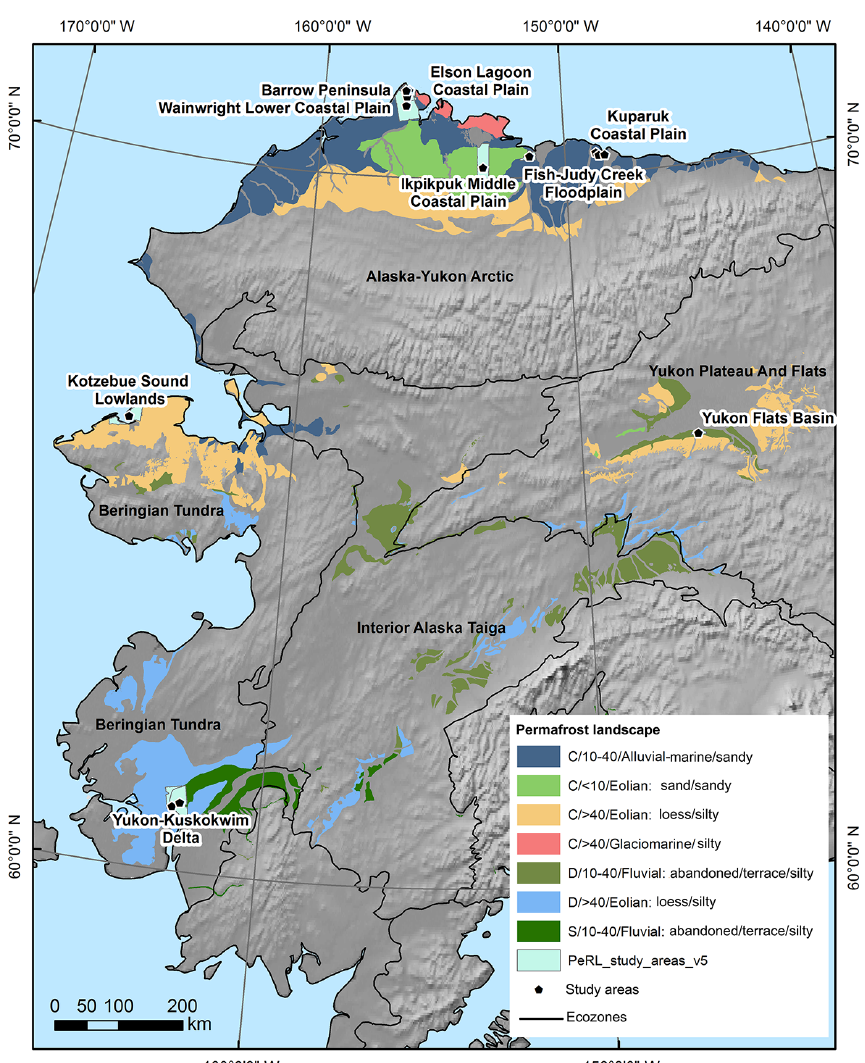
Figure D1. Study areas and associated permafrost landscapes in Alaska. Legend lists type of permafrost extent (C: continuous; D: discon- tinuous; S: sporadic), ground ice content (vol%), surficial geology, and lithology. Shadowed labels name study areas with waterbody maps. Black lines and labels denote